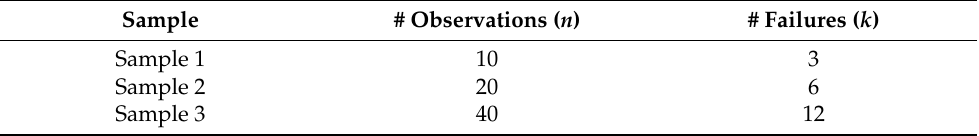
Table 1. Adopted samples with their respective observations and observed failures.